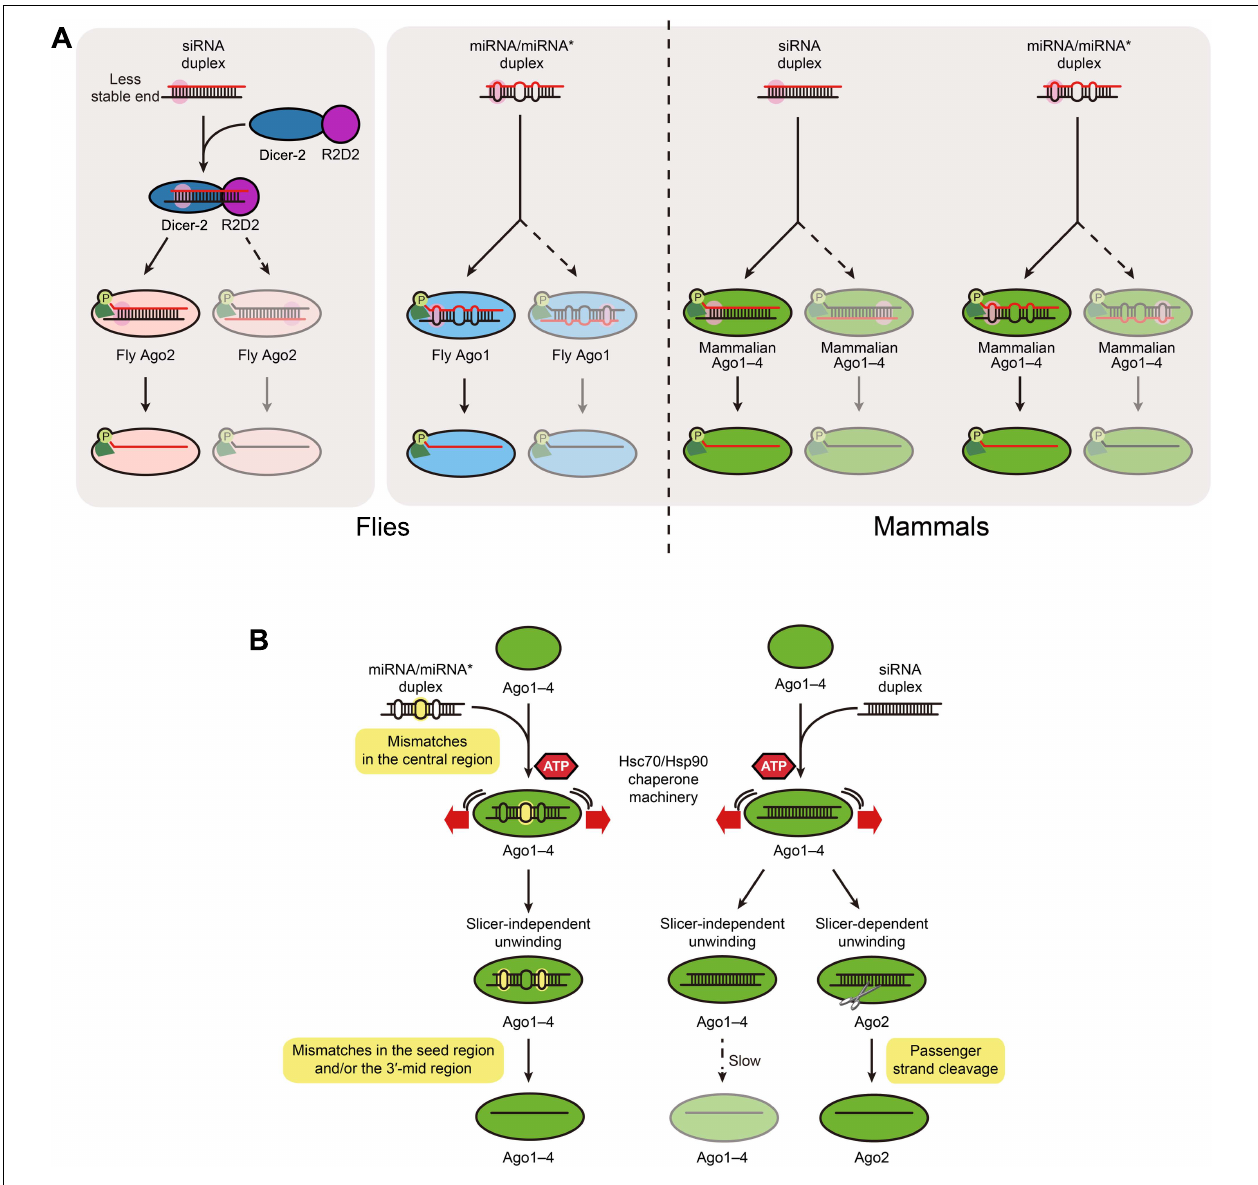
FIGURE 1 | (A) miRNA/miRNA* and siRNA duplexes are functionally asymmetric. In both flies and mammals small RNA duplexes are preferentially loaded into Ago proteins with their less stable end (pink) toward the phosphate-binding pocket of the protein (light green), which results in the selection of the red strand as the guide strand. If the duplex is occasionally loaded in the opposite orientation, the black strand functions as the guide.The more asymmetric the duplex is, the more likely the red strand is exclusively selected as the guide. Besides Ago proteins themselves and the Hsc70/Hsp90 chaperone machinery (B) , no other factors are known